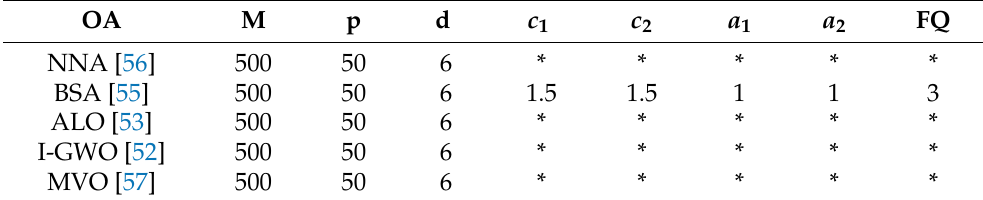
Table 3. Input parameters for OAs (* means NOT